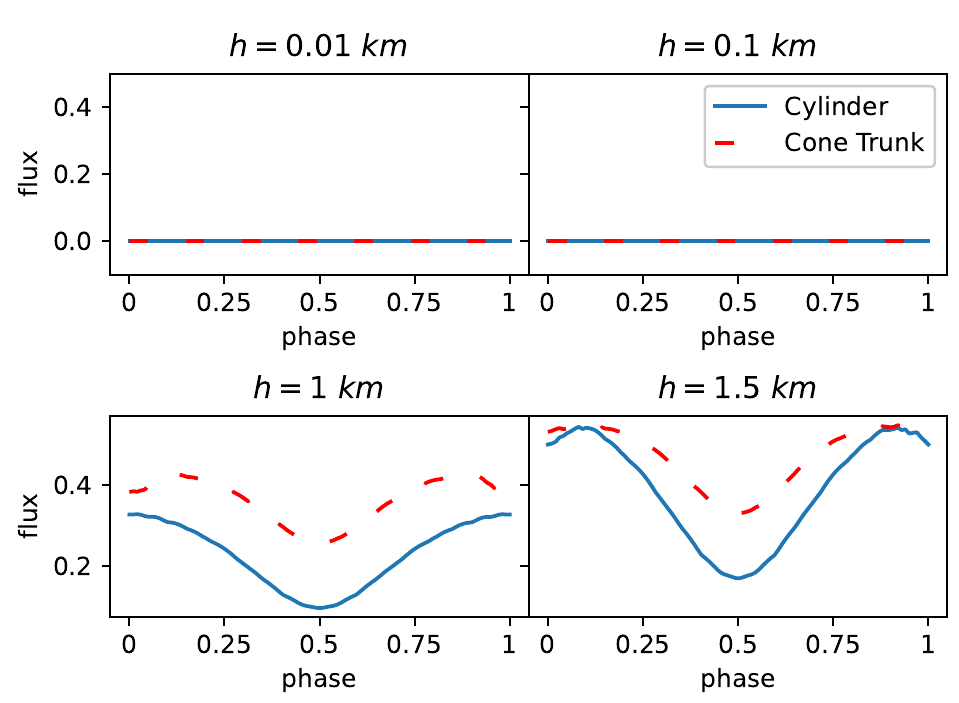
Figure 8. The fan beam phase diagrams for different column heights are shown. Blue continuous (red discontinuous) lines show results for cylindrical (cone trunks) columns. Parameters: M = 1.4 M (cid:12) , R = 12 km, i = 90 ◦ , P = 1 s, θ 10 = 15 ◦ , θ 1 = 45 ◦ , φ 1 = 180 ◦ , and T 1 = 0.7